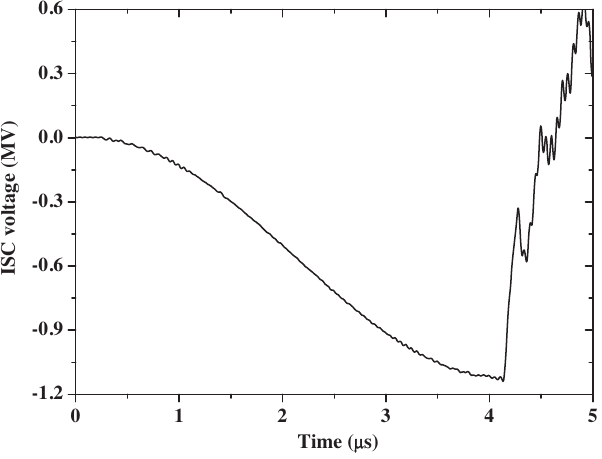
FIG. 9. The voltage pulse on ISC